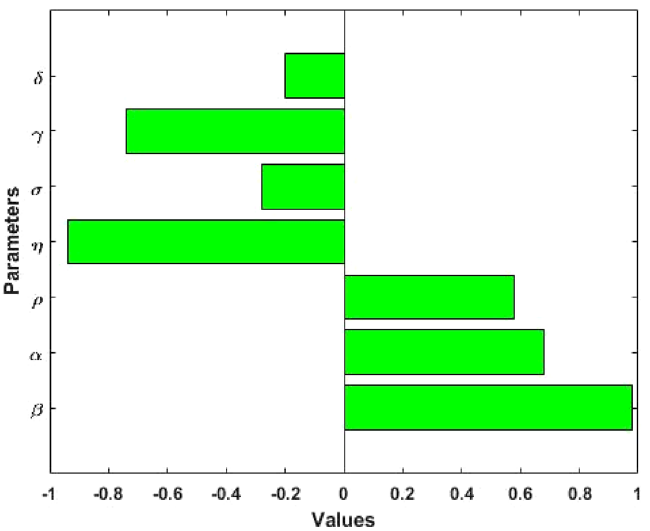
Figure 5. Correlation between basic reproduction number ( R 0 ) and the model parameters β , α , ρ , σ , γ , η and δ